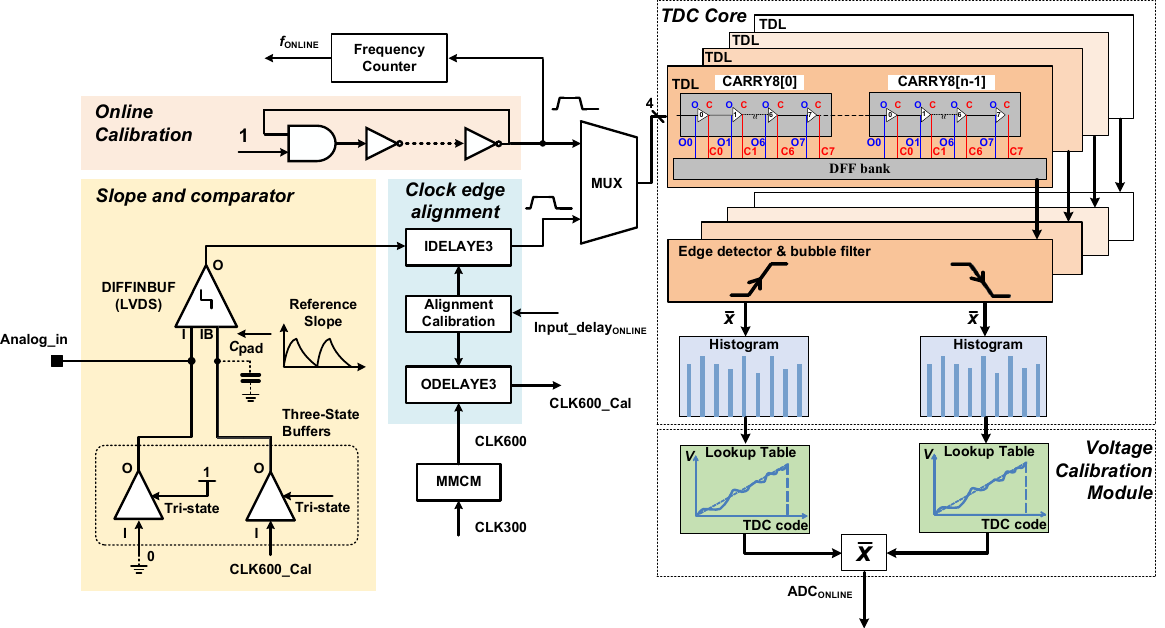
Figure 1. Overall architecture of the proposed FPGA-based ADC. The comparator module includes two single-ended output buffers OBUFT, and an LVDS comparator DIFFINBUF. The output resistance of the OBUFT with parasitic